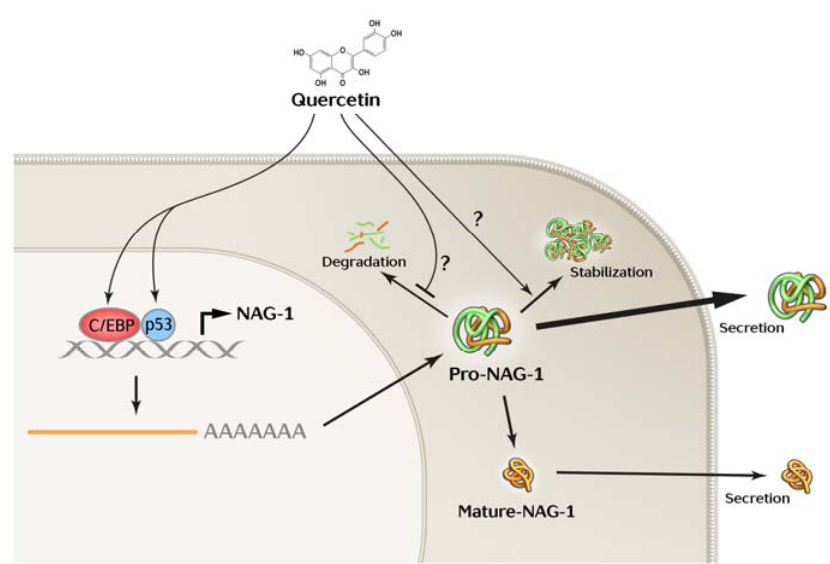
Figure 6. Proposed mechanism by which pro-NAG-1 plays an anti-tumorigenic role in thyroid cancer. Pro-NAG-1 and mature NAG-1 are produced in thyroid tissues and cancer cells. Quercetin Table S1 in human thyroid cancer, leading to an increase in pro-NAG-1 only, and not mature NAG-1.